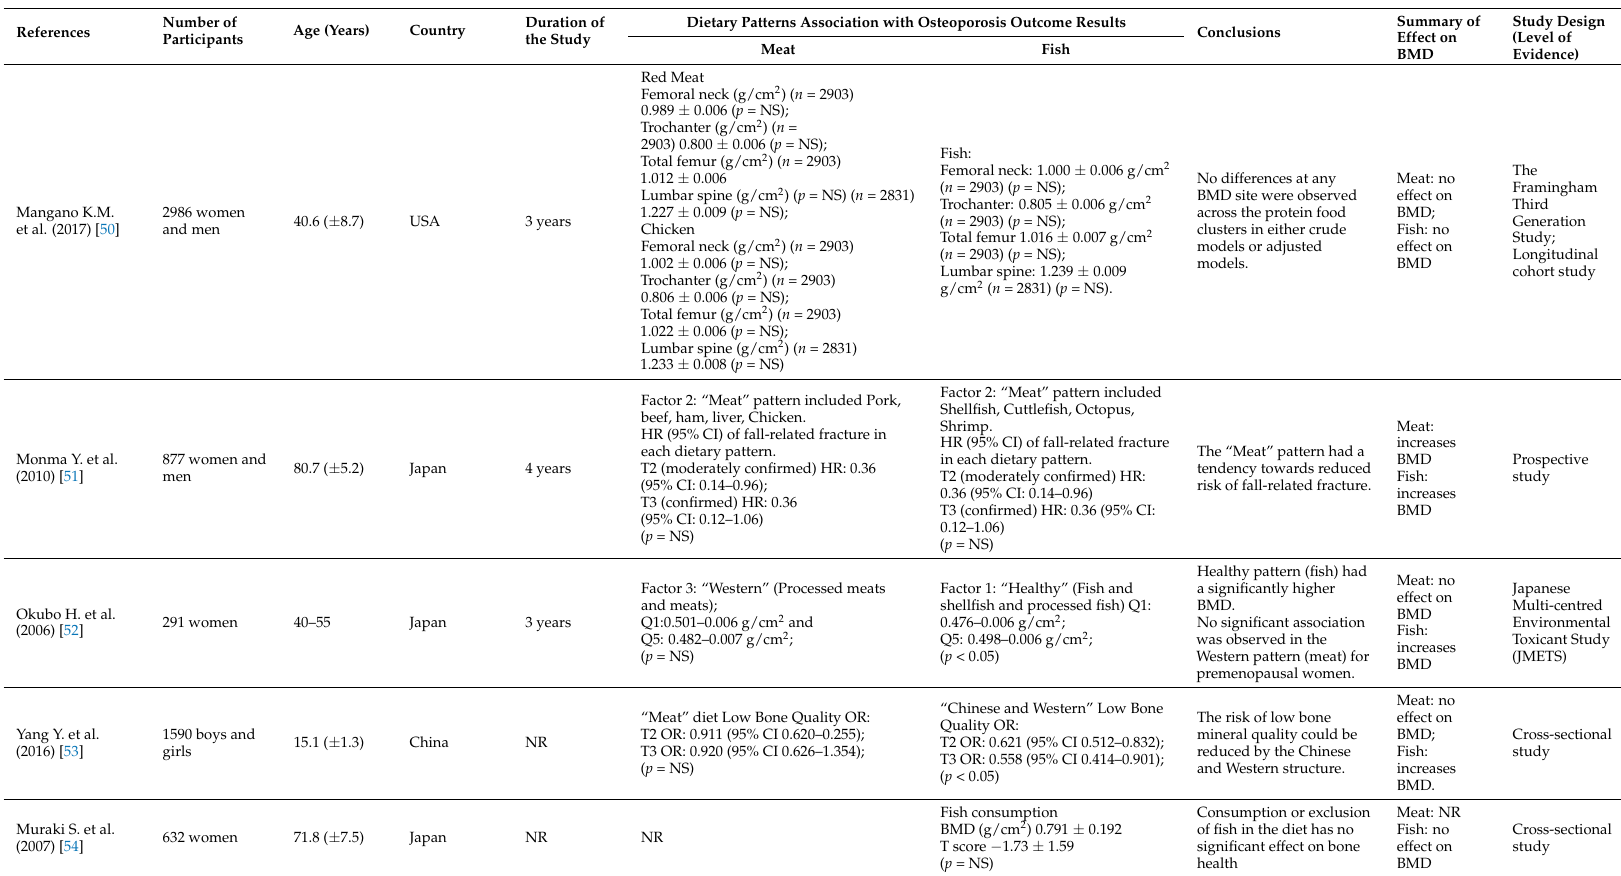
StudyDesign (Levelof